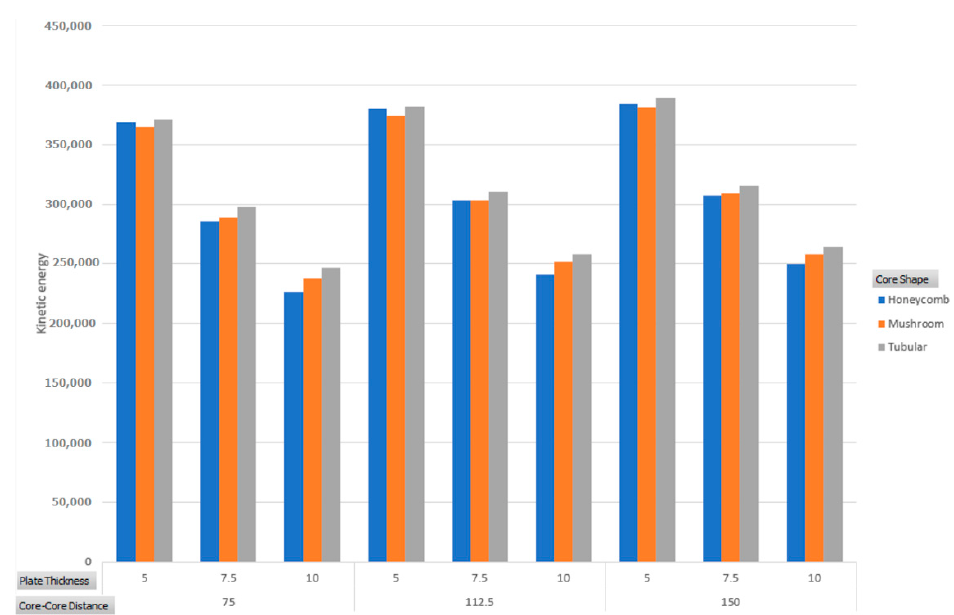
Figure 13. Maximum U3 displacement categorized by core shape, plate thickness, and core–core spacing.